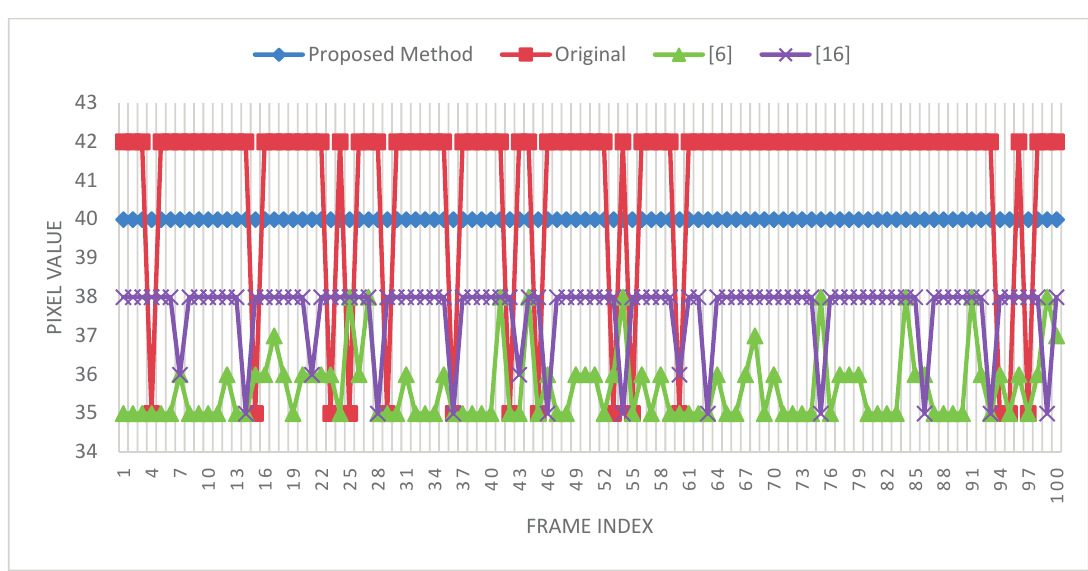
Figure 9. Temporal filtering results for 100